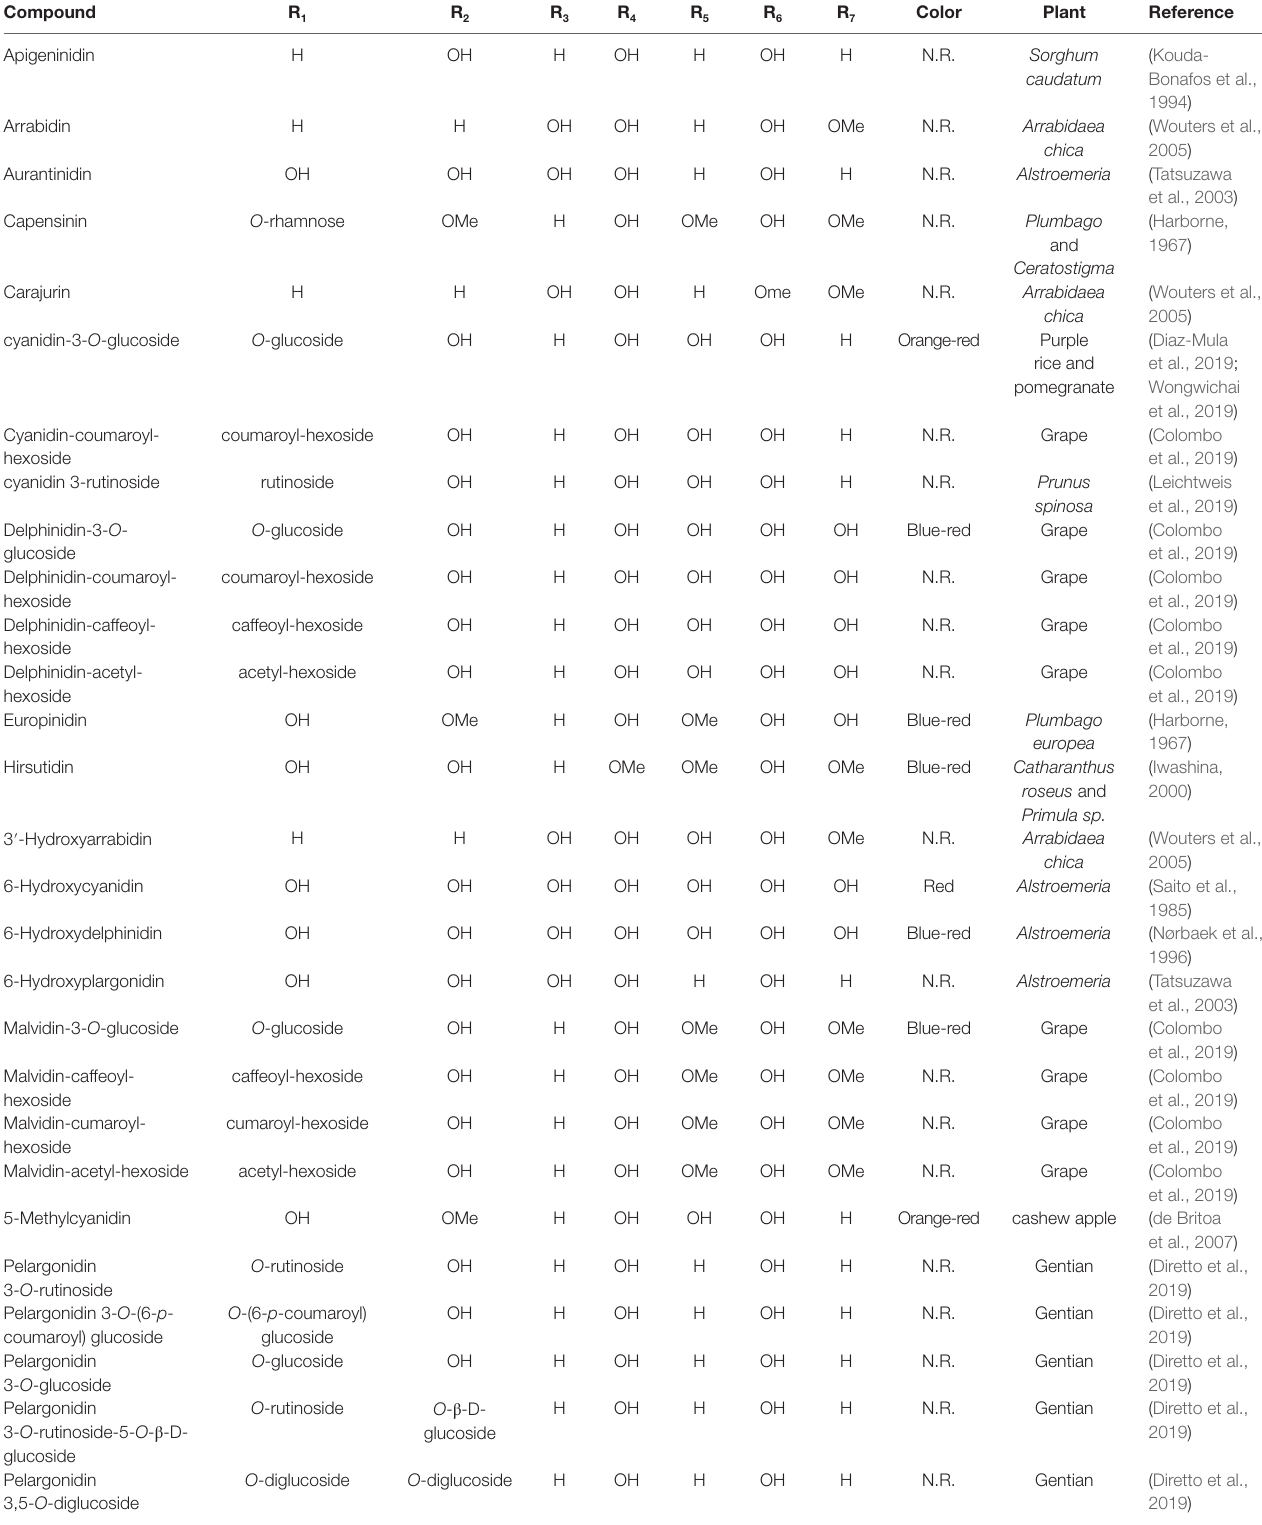
TABLE 1 | Name, substituents, color, and the plant that anthocyanins were isolated.